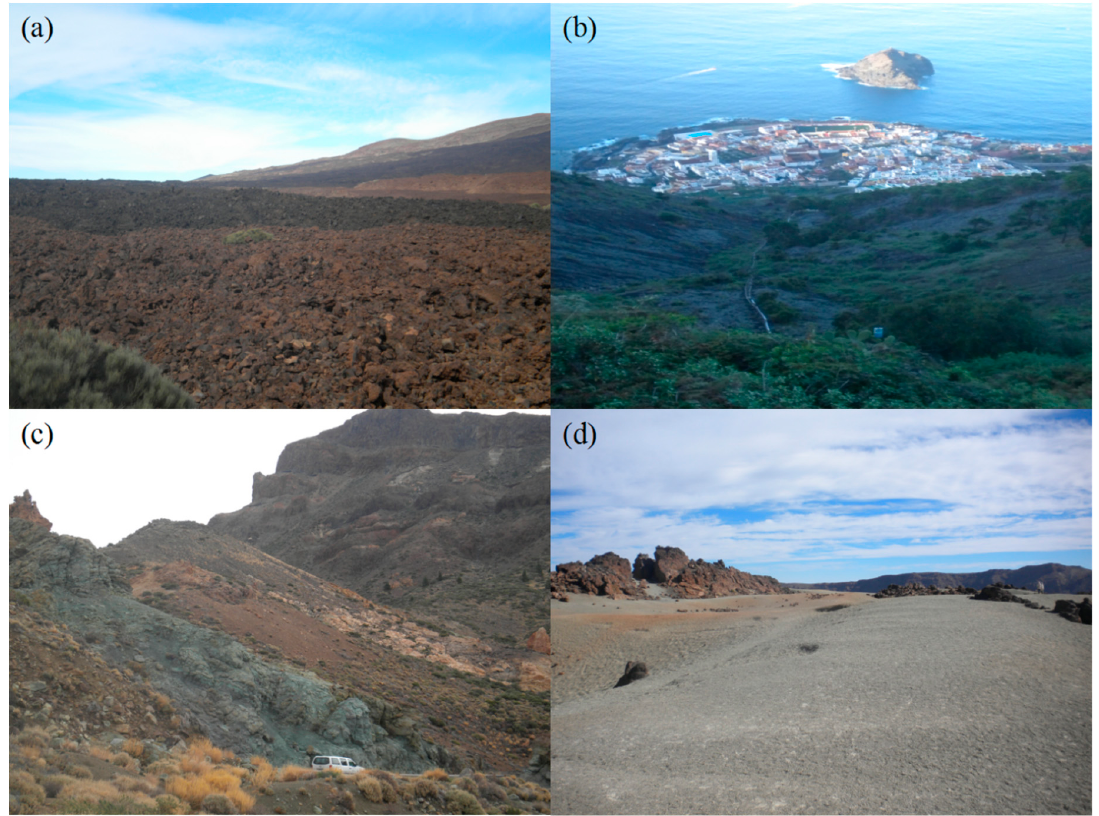
Figure 2. Volcanic landscape on Tenerife. ( a ) Historical lava flows within the Las Cañadas caldera. ( b ) Lava in proximity to Garachico, a northwestern Tenerife municipality once destroyed by lava flows but later re-built on them. ( c ) Historical PDCs. ( d ) Historical tephra. Photos were taken by Prof. Dr.